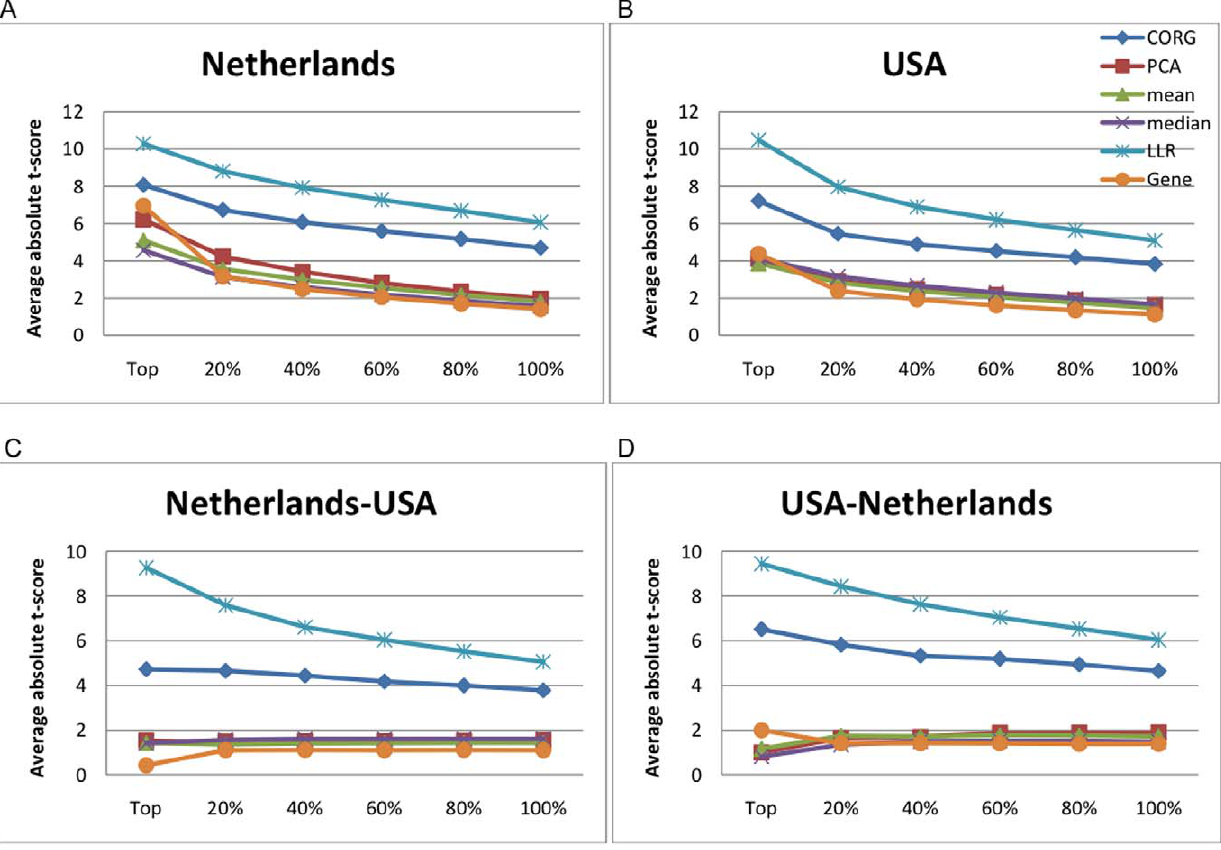
Figure 4. Discriminative power of all pathway markers and gene markers. (A) Mean absolute t -score of the top P % markers for the Netherlands dataset. (B) Mean absolute t -score of the top markers for the USA dataset. (C) The markers were ranked based on the Netherlands dataset and the mean absolute t -score of the top P % markers was computed based on the USA dataset. (D) The markers were ranked based on the USA dataset and the mean score of the top P % markers was computed based on the Netherlands dataset.